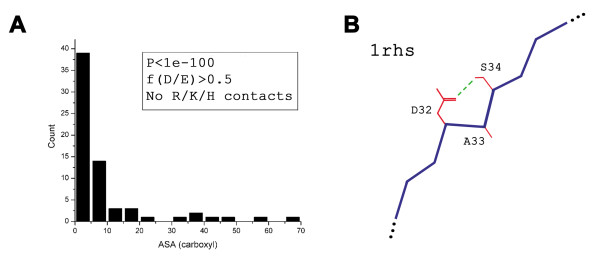
Structural environments for protein positions that show discrepancy between observed residue frequencies and their structure-based predictions. A. Histogram of accessible surface areas (ASA) for D/E residues at the positions that show largest discrepancy (P < 10-100), correspond to elevated frequencies of D/E among sequence homologs (effective frequencies more than 0.5), and do not contact with positively charged R, K or H residues. B. An example local structural distortion caused by contacts of buried acidic residues. A fragment of structure (PDB ID 1 rhs) with aspartate beta bulge is shown. Backbone is colored with blue, sidechains with red. Contact formed by aspartate D32 through the side chain oxygen is marked.